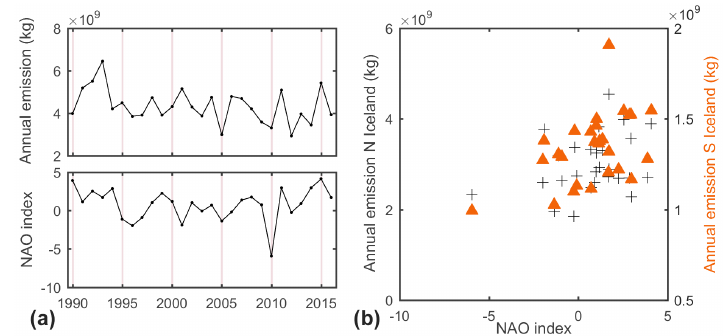
Figure 8. (a) Annual dust emission from Iceland in years 1990 until 2016 (top panel) and the annual NAO index (bottom panel). (b) Annual emission from northern Iceland ( > 64 . 3 ◦ N) and southern Iceland ( < 64 . 3 ◦ N) vs. annual NAO index.